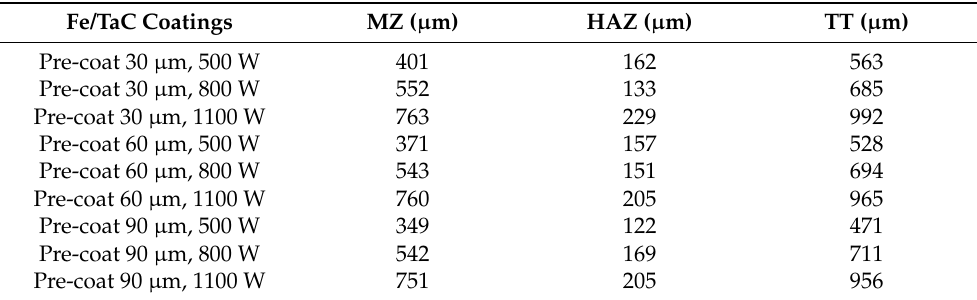
Table 2. Thickness of laser tracks (MZ—melted zone, HAZ—heat affected zone, TT—total thickness).